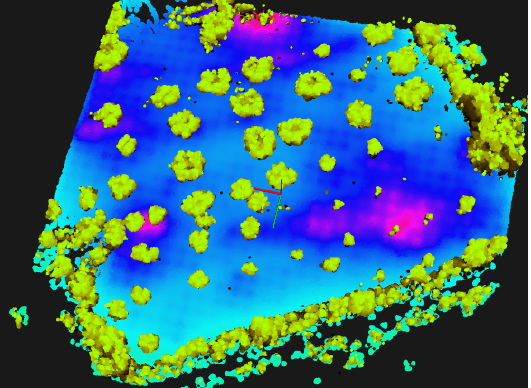
Figure 27. Heatmaps: GMC estimation in Counts per Minute from local C when at 1 m above the ground. Data collected on foot. Maximum estimated value is 164